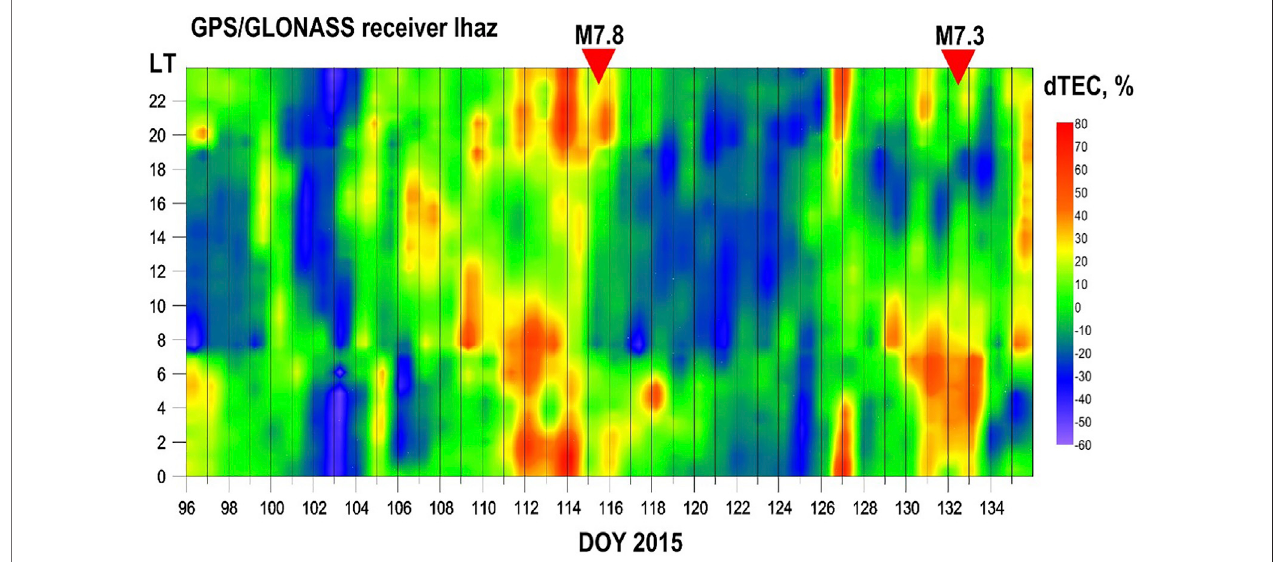
FIGURE 10 | GIM GPSffEC spatial analysis. (A) Differential TEC map of April 21, 2015, ( − 4 days) 09UT and (B) April 24, 2015, 08UT ( − 1 day) (C) Differential TEC map of May 5, 2015, ( − 7 days) ! OUT and (D) May 5, 2015, 12UT ( − 7 day).